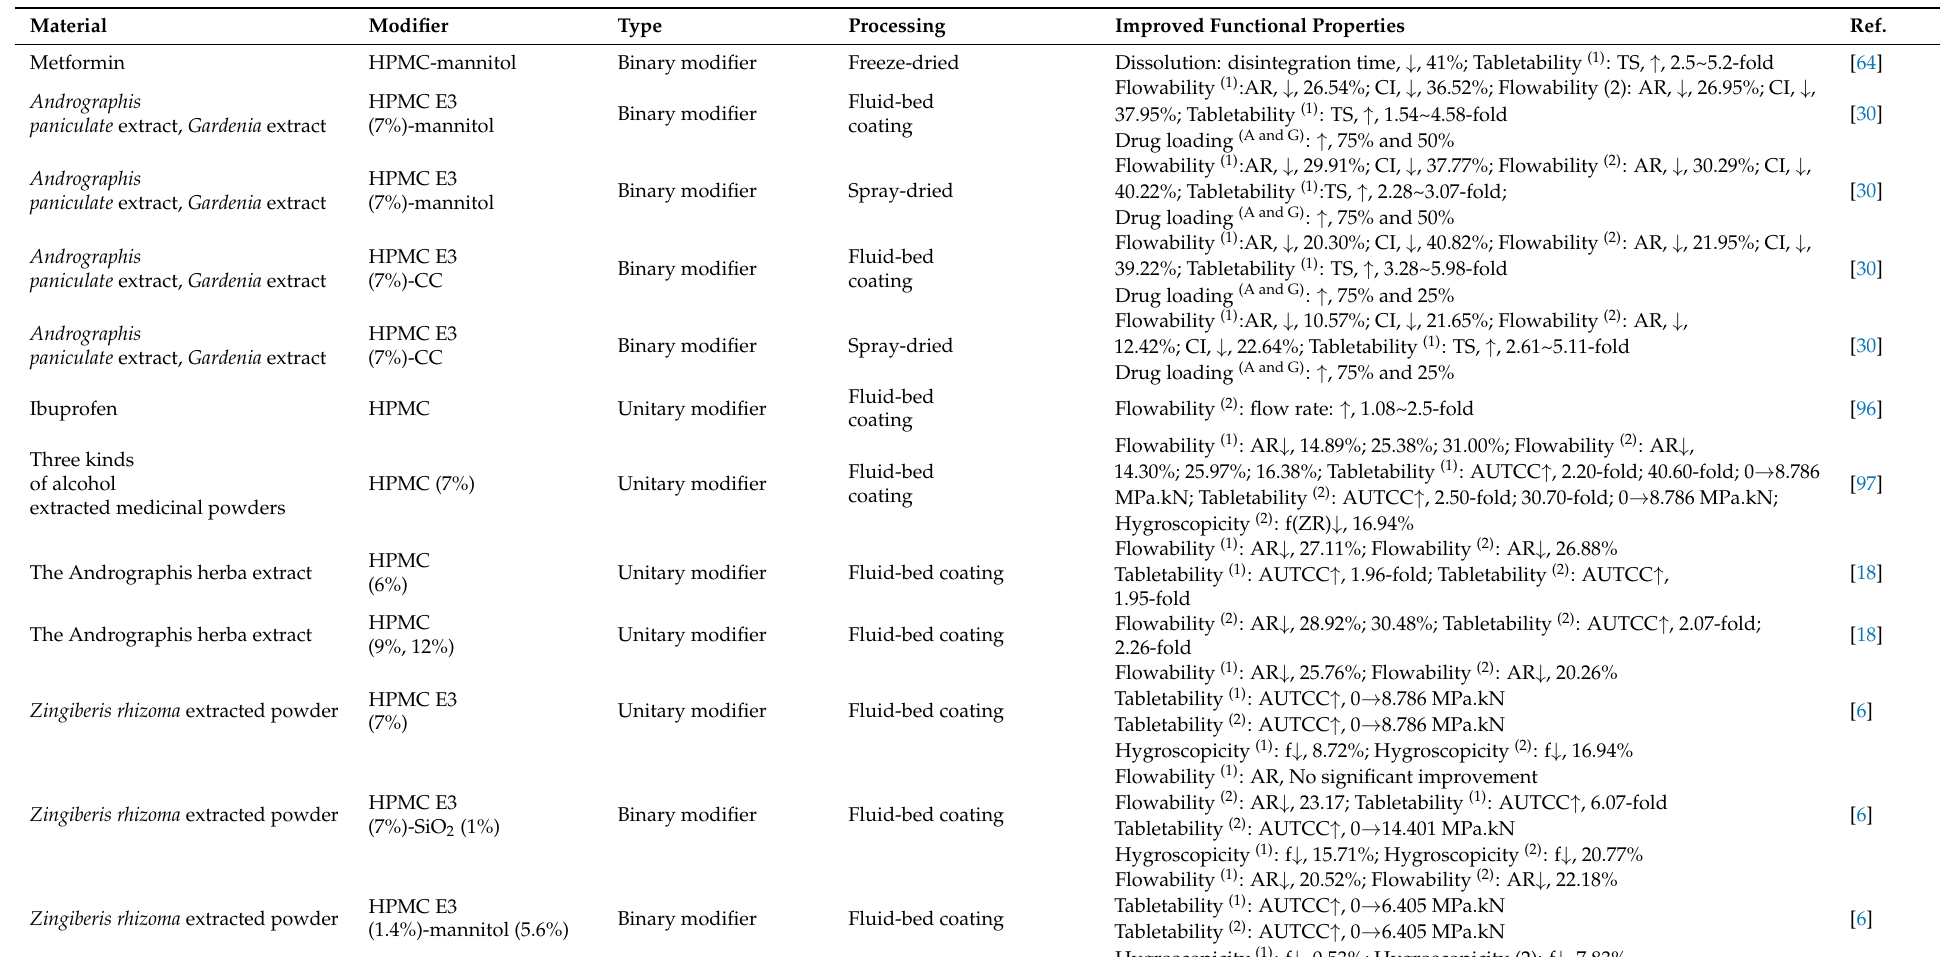
Table 1. The application of